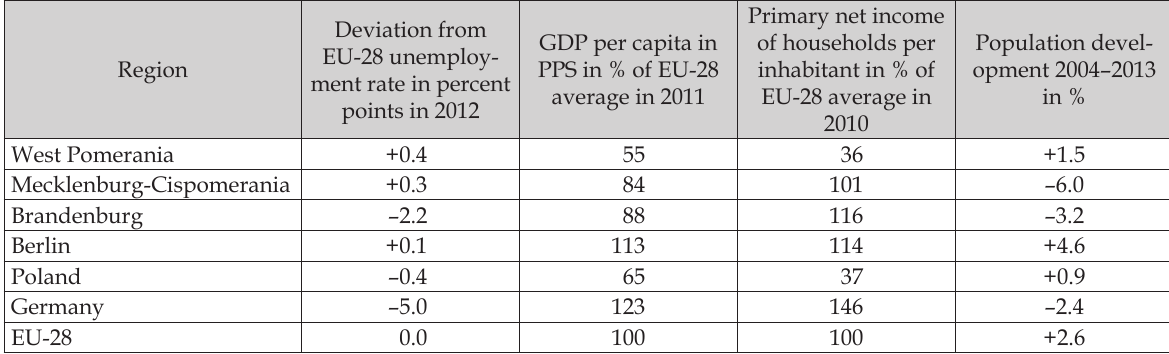
Table 2. Key figures of the study regions (NUTS-2) in the EU perspective.